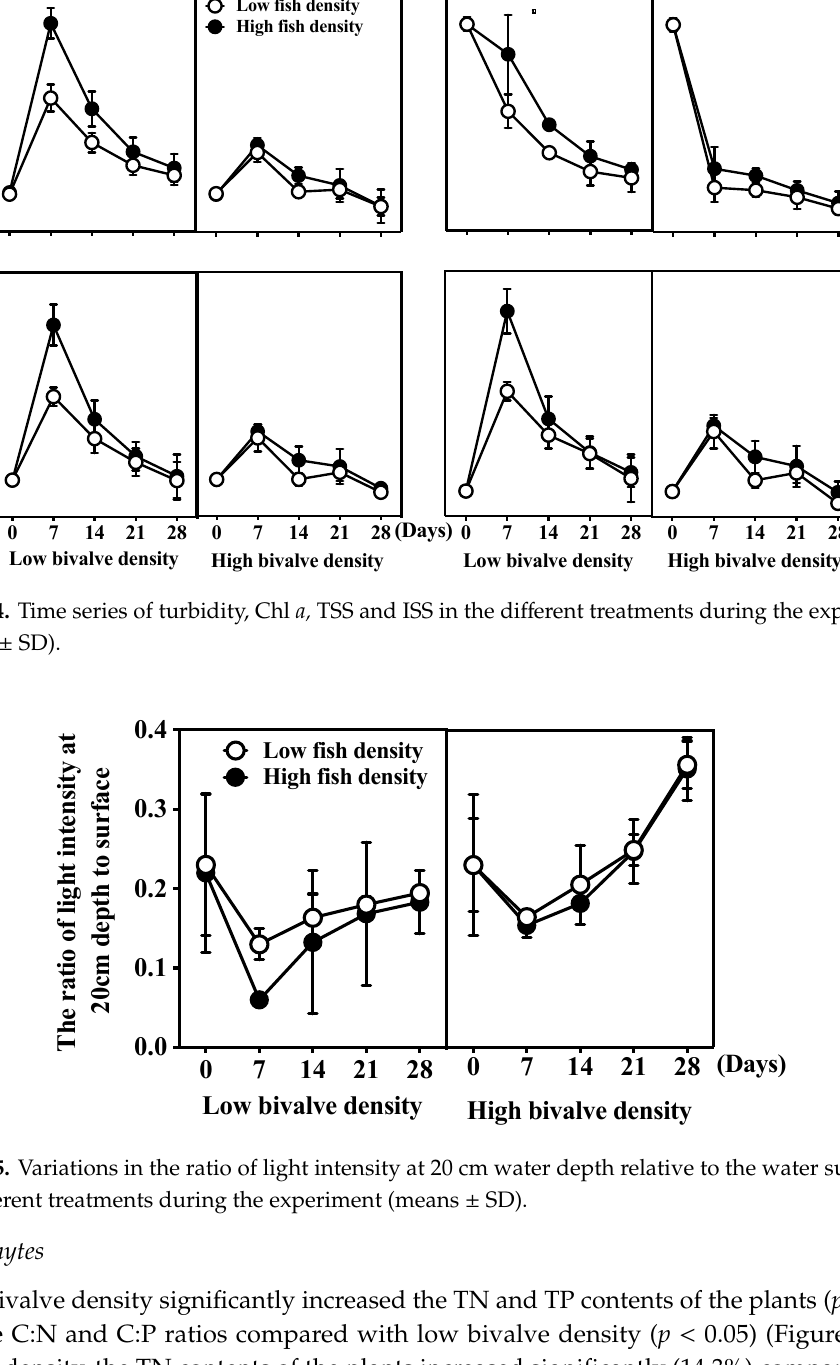
Figure 5. Variations in the ratio of light intensity at 20 cm water depth relative to the water surface in the different treatments during the experiment (means ± SD).